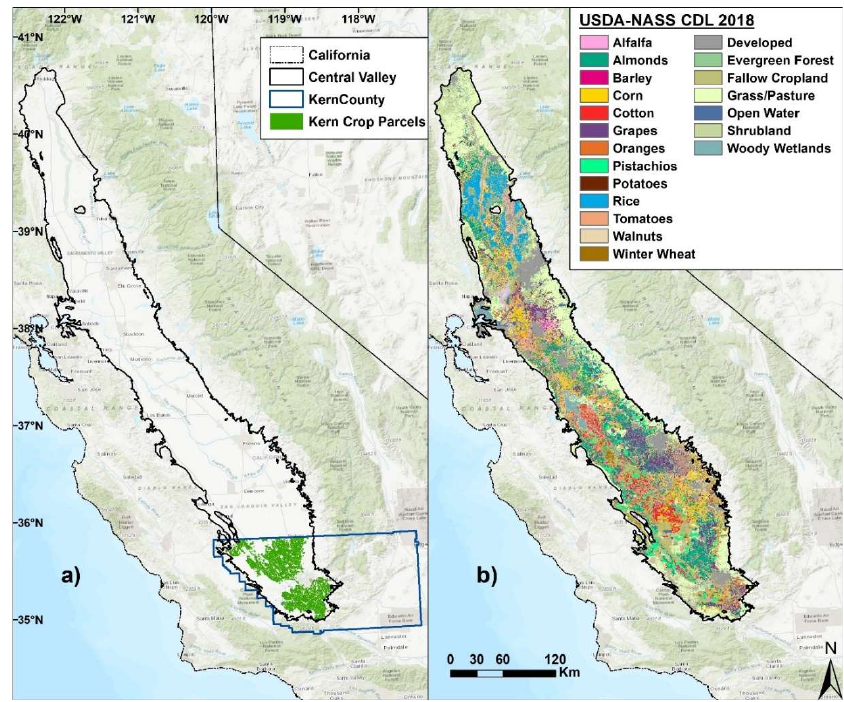
Figure 1. The Central Valley of California showing ( a ) the valley boundary used in this study along with Kern County and the Kern County Crop Parcels; and ( b ) the 2018 U.S. Department of Agriculture, National Agricultural Statistics Service (USDA-NASS) Cropland Data Layer for the Central